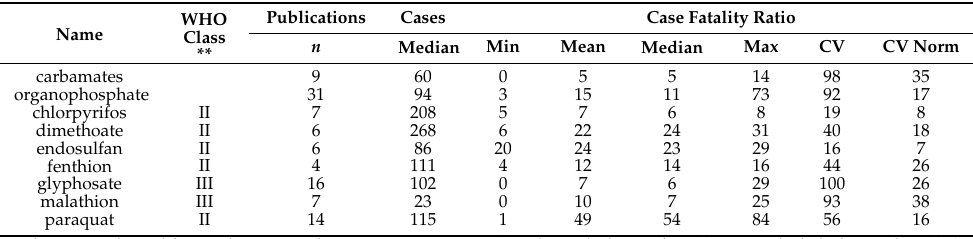
Figure 2. Median case-fatality-ratios (%) for active ingredients of pesticides and WHO hazard classes. E = extremely hazardous, H = highly hazardous, M = moderately hazardous, S = slightly hazardous, U = unlikely to present acute hazard. Some pesticides with high human case-fatality are inappropriately classified. Agents stated “obsolete” or “VF” not shown. Table 4. Variability of case-fatality-ratios (%) for pesticides